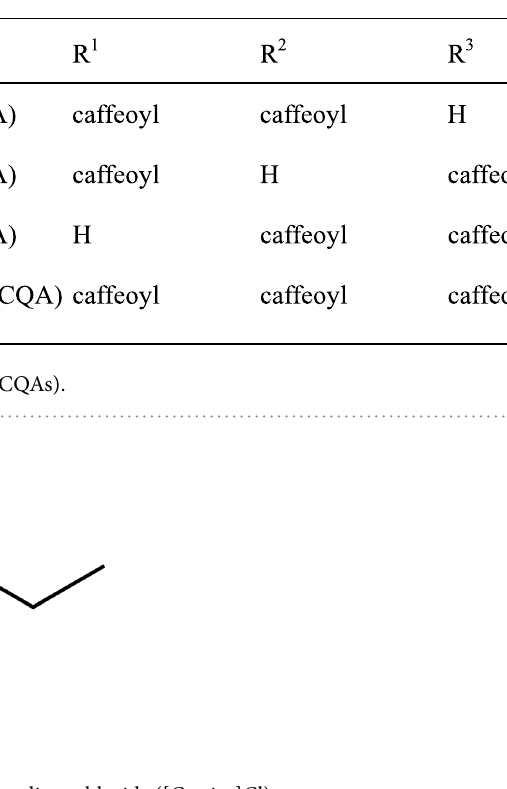
Figure 2. Structure of 1-butyl-3-methylimidazolium chloride ([C 4